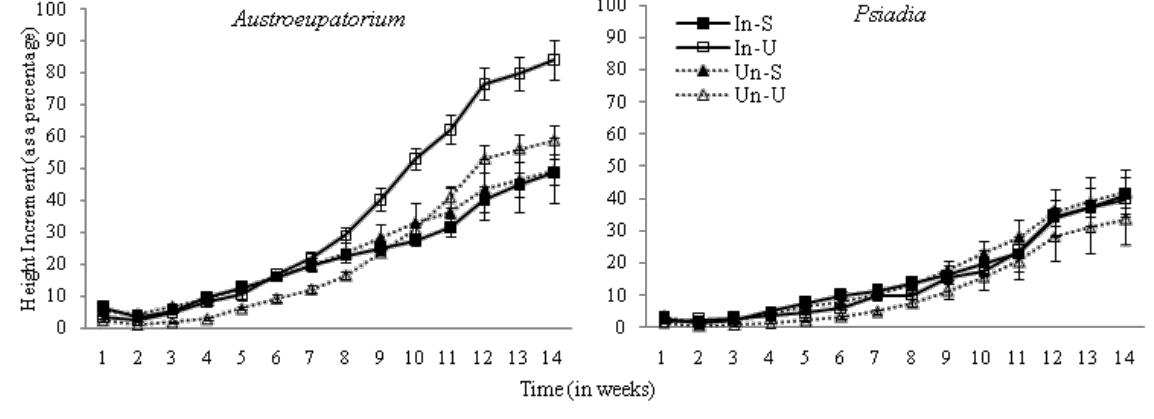
Figure 2: Cumulative increase in height (as a percentage) of Austroeupatorium and Psiadia during the experimental period grown under differently-treated soils; invaded/sterilized (In-S), invaded/un-sterilized (In-U), un-invaded/sterilized (Un-S) and un-invaded/un-sterilized (Un-U). Error bar represents the standard error of the mean (SEM)